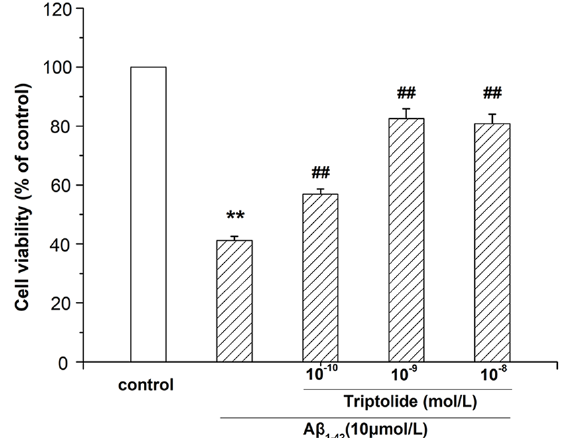
Figure 3. Protective effect of triptolide on cytotoxicity induced by Aβ . A culture media (10 μmol/L Aβ +10 -8 1–42 1-42 mol/L triptolide, 10 μmol/L Aβ , 10 μmol/L Aβ +10 - 1-42 1-42 10 mol/L triptolide, and 10 μmol/L Aβ +10 -9 mol/L 1-42 triptolide) was used to treat the PC12 cells for 24 h. A CCK-8 assay was used to measure the viability of the cells, while the outcomes were represented by the absorbance percentage as compared to the control group. Data was calculated as the mean ± S.E.M. n=6/ group. ** P < 0.01 vs. control group. ## P < 0.01 vs. 10 μmol/L Aβ 1-42